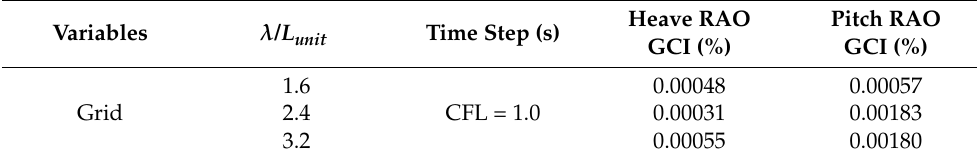
Table 5. Comparison of the motions under the wave conditions (H / λ = 0.03).